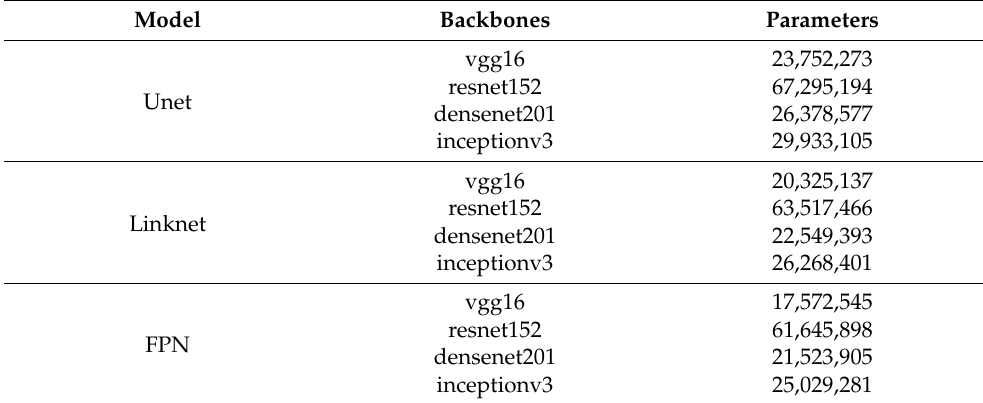
Table 3. Total number of parameters for each